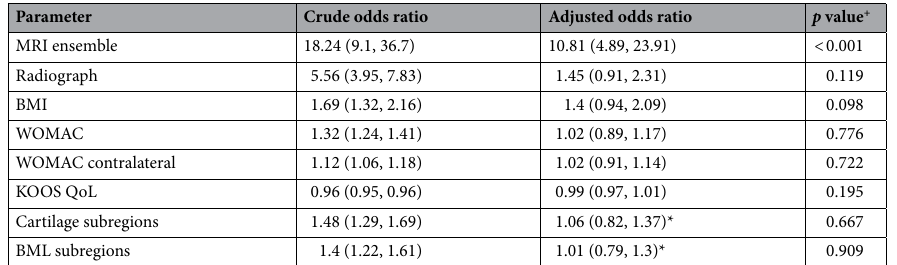
Table 2. Crude odds ratio (OR) and adjusted OR indicating the ability of different variables to predict total knee replacement (TKR) in univariate and multi-variate conditional logistic regression models for all knees combined. Data in parenthesis are 95% confidence intervals. Analysis of cartilage and BML subregions was performed on a subset of the study cohort due to missing semi-quantitative MOAKS. BMI Body mass multivariable analysis uses clinical risk factors and image readings from 270 case–control patients. + Wald test was used to assess the significance levels of individual risk factors.